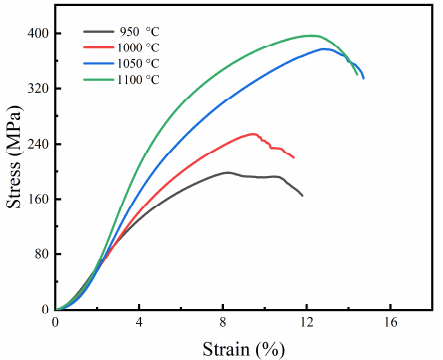
Figure 6. The compressive behavior of porous NiTi specimen.